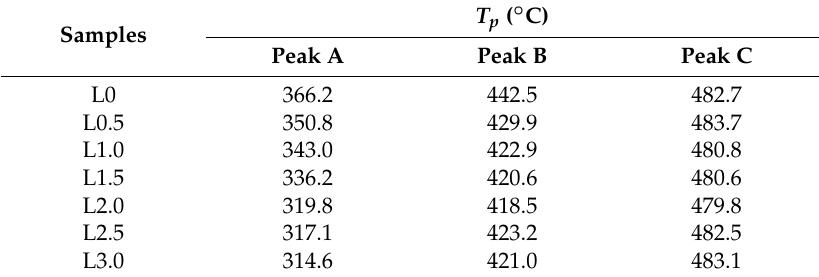
Table 3. Degradation temperature values derived from thermogravimetric analysis.